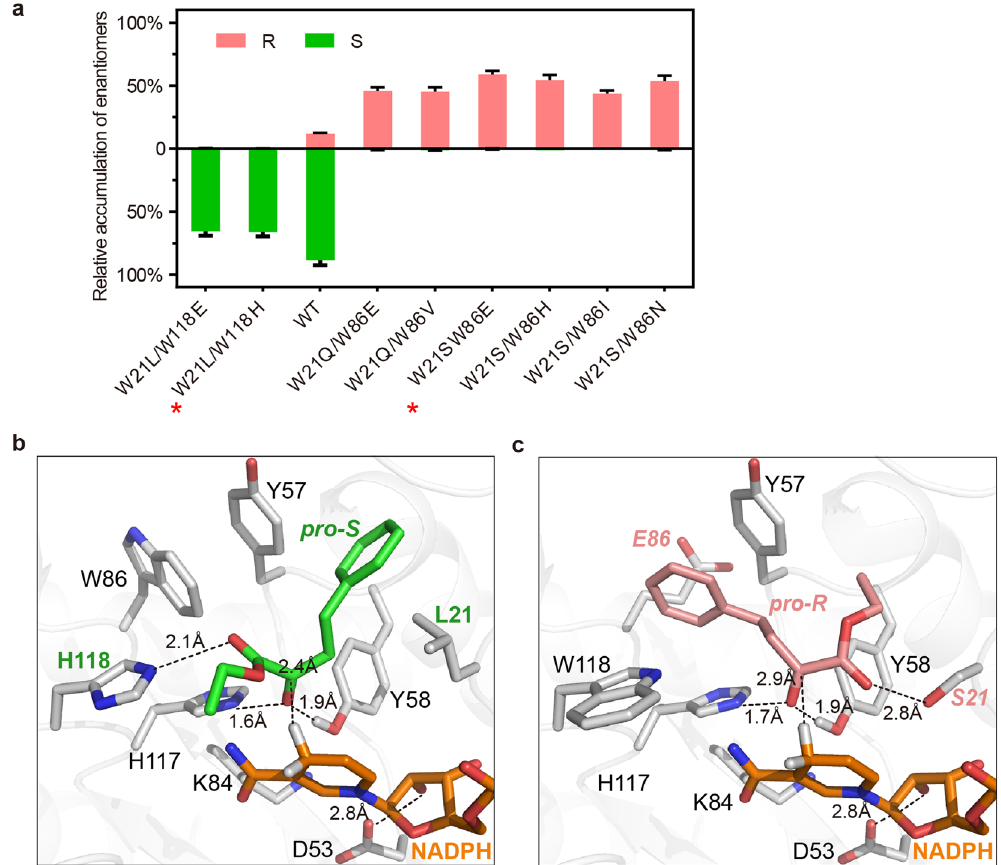
Figure 5. The optimal (S)-EHPB- and (R)-EHPB-preferring Tm1743 double mutants and models of their EOPB binding conformations. ( a ) The percentage of (S)-EHPB (green) and (R)-EHPB (salmon) produced by different Tm1743 double mutants. ( b ) and ( c ) Stereo views of the EOPB binding models of the best (S)-EHPB- preferring (W21L/W118H) and (R)-EHPB-preferring (W21S/W86E) mutants. Amino acids involved in EOPB coordination are shown as gray sticks, and the pro - S and pro - R conformations of EOPB are colored green and salmon, respectively. NADPH is shown as orange sticks.